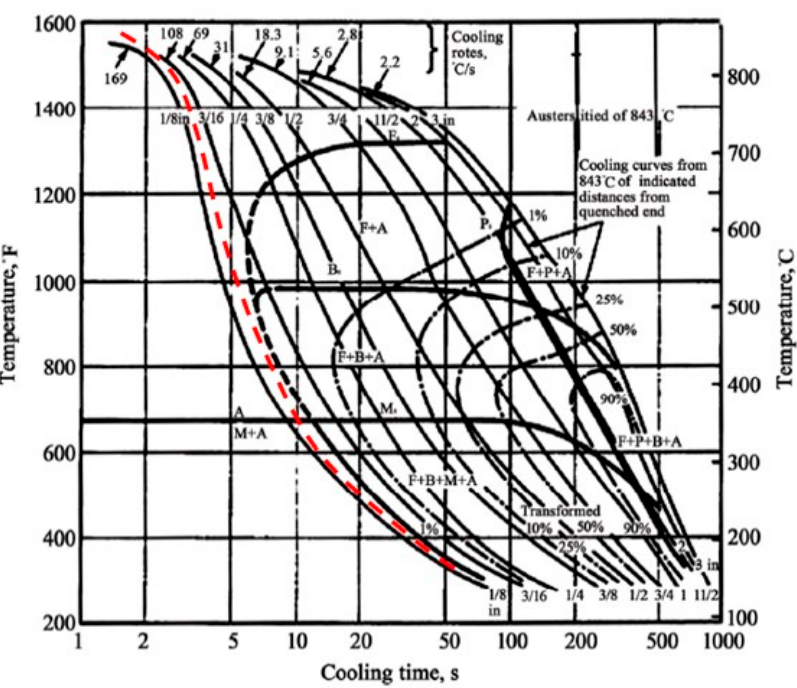
Figure 19. Continuous cooling transformation (CCT) diagram for AISI 4130 and cooling speed during the heat treatment (dotted curve).